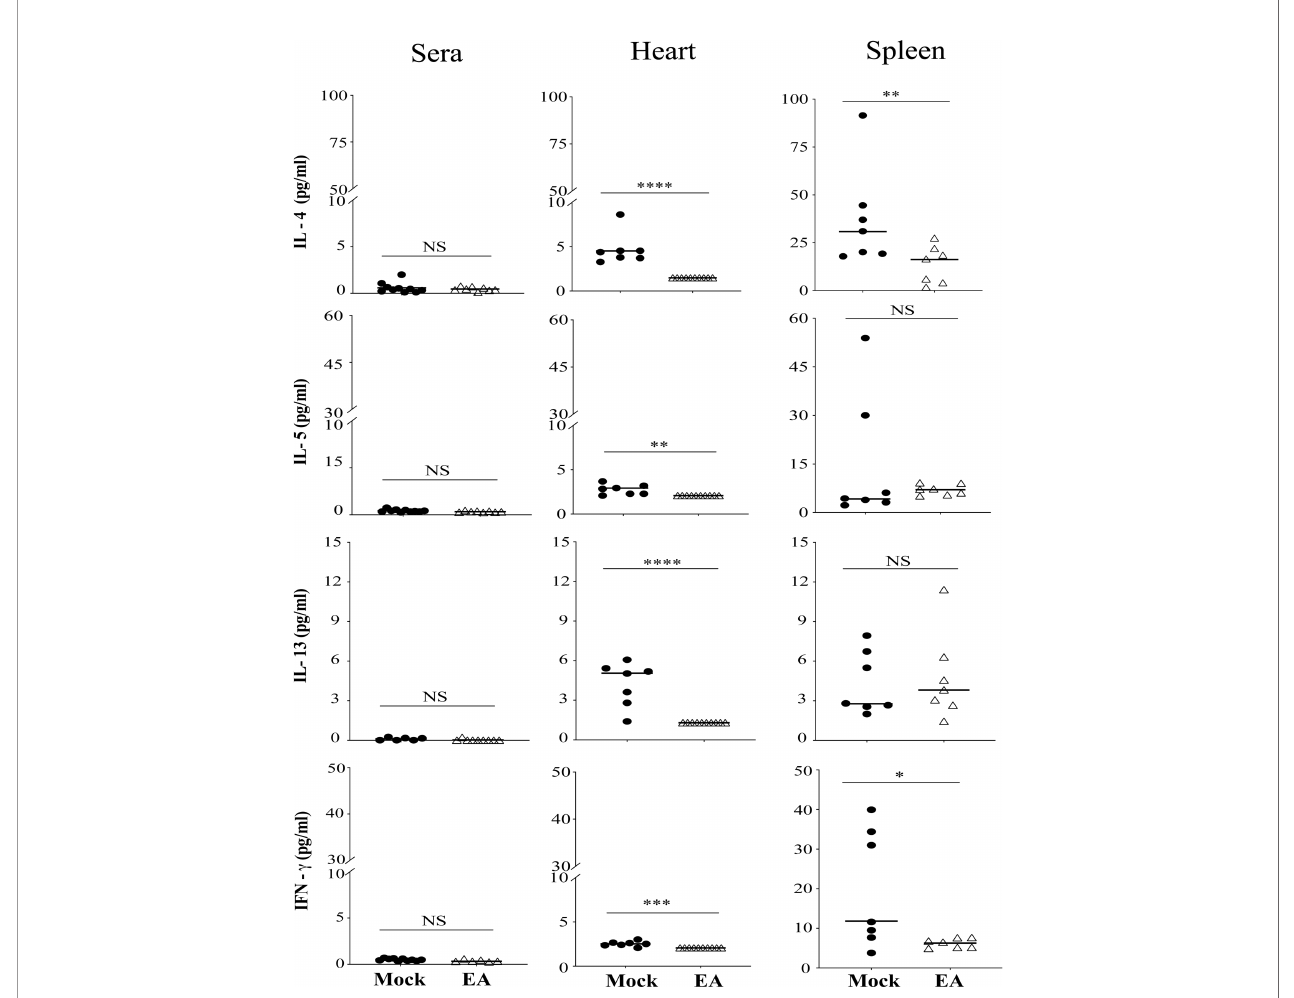
FIGURE 5 | Effect of EA treatment on cytokines production by CD4+ Th1 and Th2 cells in serum, spleen, and heart extracts of Borrelia burgdorferi -infected C3H/ HeJ male mice. IL-4, IL-5, and IL-13 cytokines that are primarily produced by Th2 cells were reduced signi fi cantly in heart after EA treatment while proin fl ammatory Type II IFN- g cytokines were reduced signi fi cantly in heart as well as spleen. Overall lower levels of these cytokines were detected by LEGENDplex in EA-treated mice in this study. Bars indicate median values. Statistical analysis was conducted using two-tailed unpaired Student ’ s t-tests for unequal variance to determine signi fi cant difference between the paired groups (NS-Not signi fi cant, *p < 0.05, **p < 0.01, ***p < 0.001, ****p < 0.0001). EA,